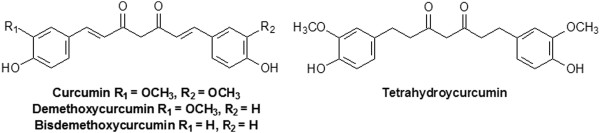
Chemical structure of curcuminoids and the metabolite tetrahydrocurcumin.